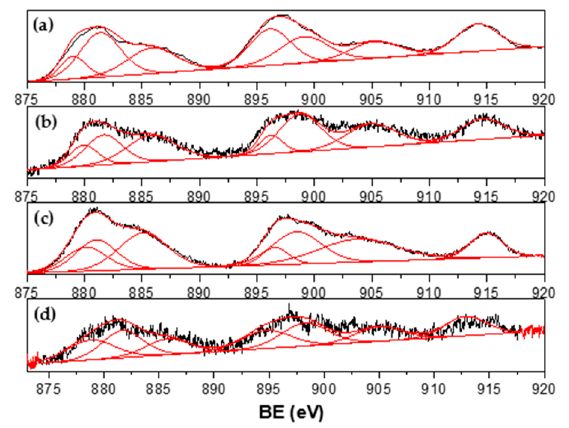
Figure 9. Ce 3d 3 / 2,5 / 2 XPS spectra of supported Ni 1-x Co x / La 0.8 Ce 0.2 catalysts. ( a ) Co; ( b ) Ni 0.1 Co 0.9 ; ( c ) Figure 9. Ce 3d 3/2,5/2 XPS spectra of supported Ni 1-x Co x /La 0.8 Ce 0.2 catalysts. ( a ) Co; ( b ) Ni 0.1 Co 0.9 ; ( c ) Ni 0.4 Co 0.6 ; and ( d ) Ni 0.7 Co 0.3.